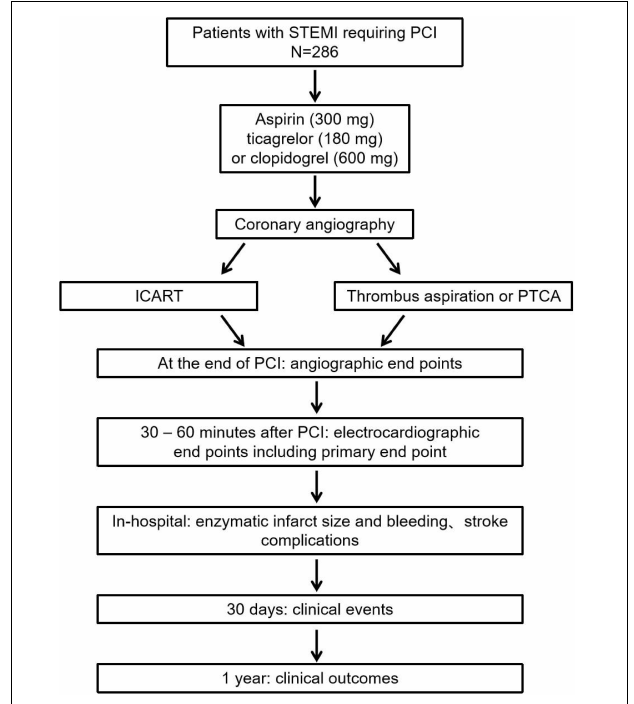
FIGURE 1 | The ICART trial flow chart. ICART, intracoronary artery retrograde thrombolysis; STEMI, ST-segment elevation myocardial infarction; PCI, percutaneous coronary intervention; PTCA, percutaneous transluminal coronary